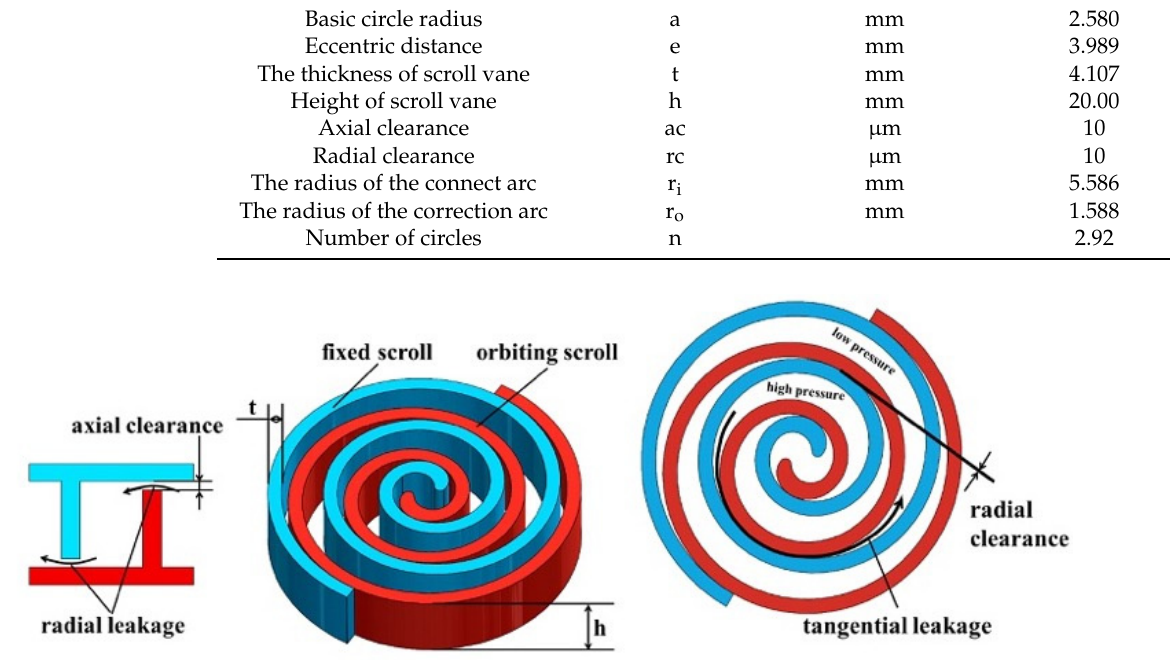
Figure 2. Geometric parameters of the scroll compressor. Table 1. The main parameters of the scroll compressor.